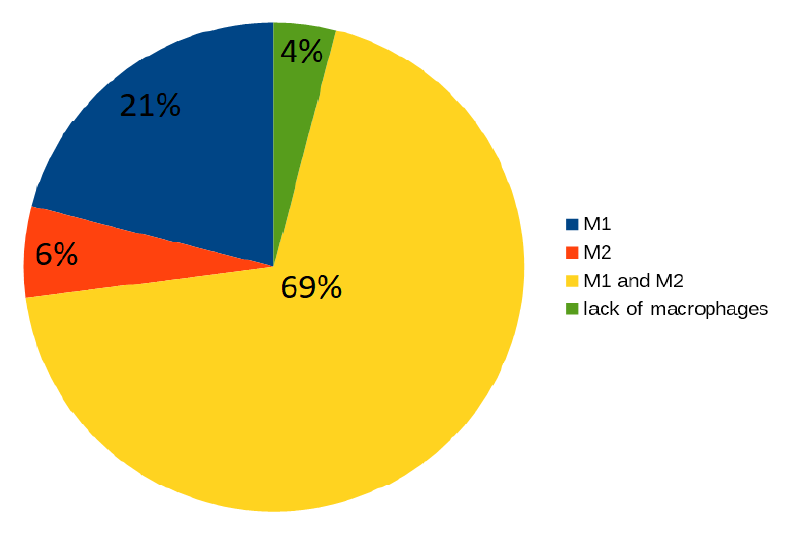
Figure 3. The diagram presents a count of t-invariants corresponding to subprocesses in which different types of macrophages are